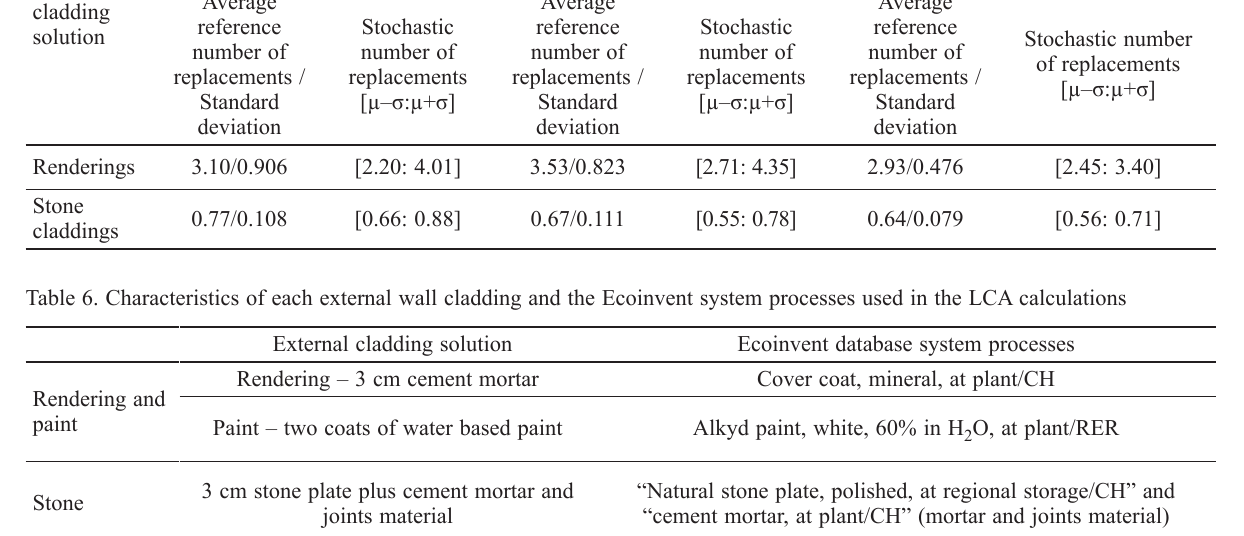
external cladding